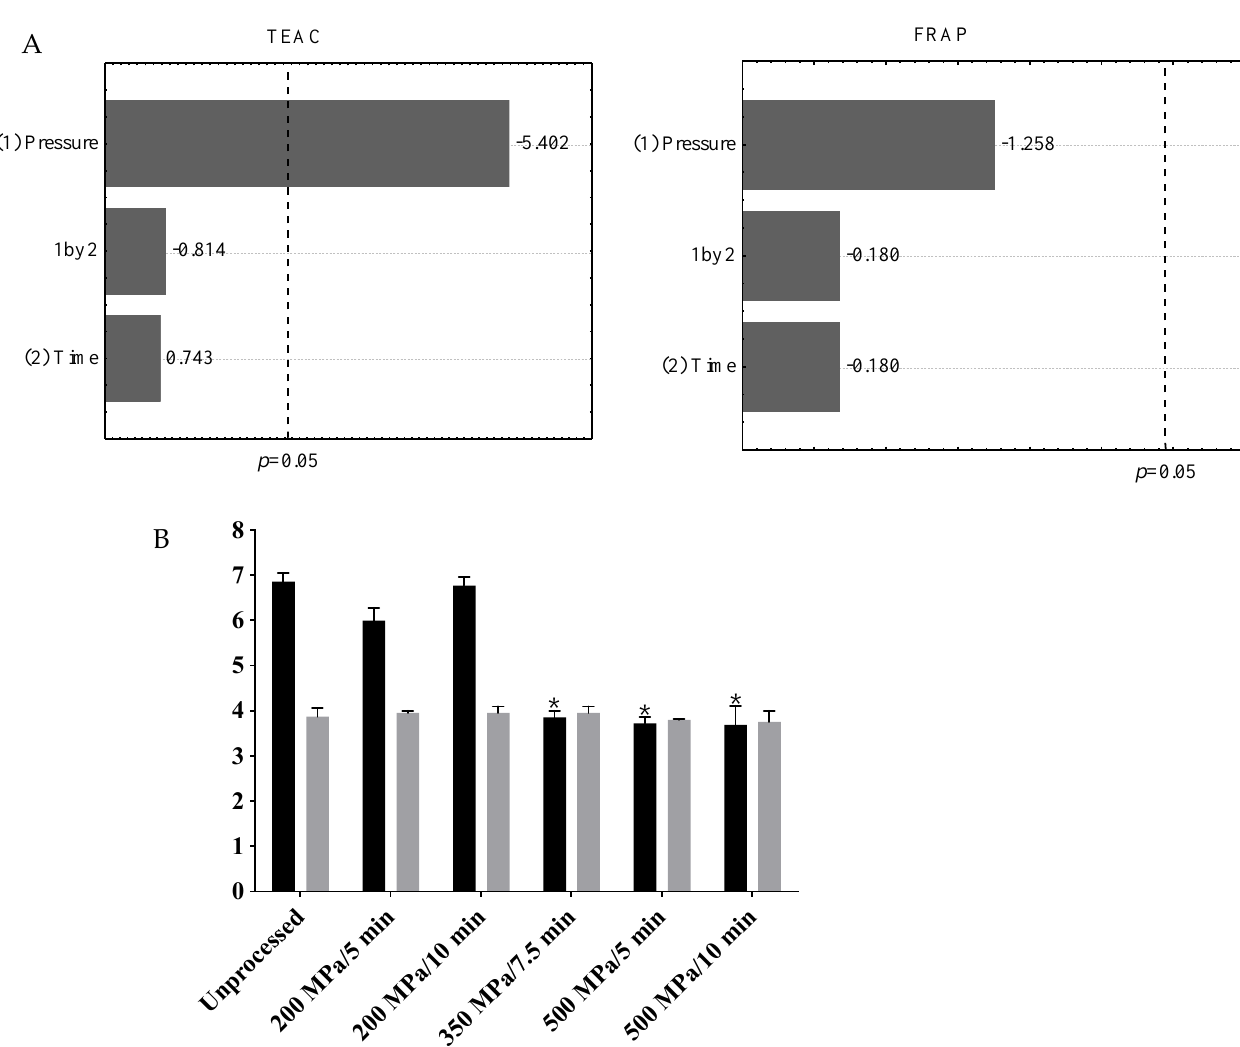
Figure 3. ( A ) Antioxidant activity of jussara juice assessed by TEAC, but not by FRAP, was affected by pressure during HHP processing. In these Pareto charts, the standardized effects that reached the dotted line ( p = 0.05) are statistically significant. ( B ) Antioxidant activity assessed by TEAC ( (cid:4) ; mmol Trolox/100 mL) and FRAP ( (cid:4) ; mmol Fe 2+ /100 mL) assays of unprocessed and HHP-processed jussara juices. Asterisks indicate significant differences from the unprocessed juice (one-way ANOVA followed by Dunnett’s post hoc test, p < 0.05).